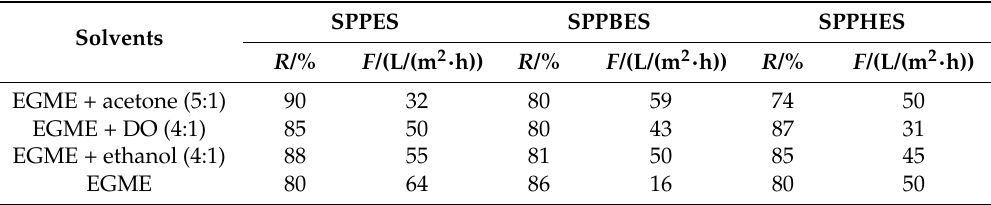
Table 4. Effect of solvents used in the coating